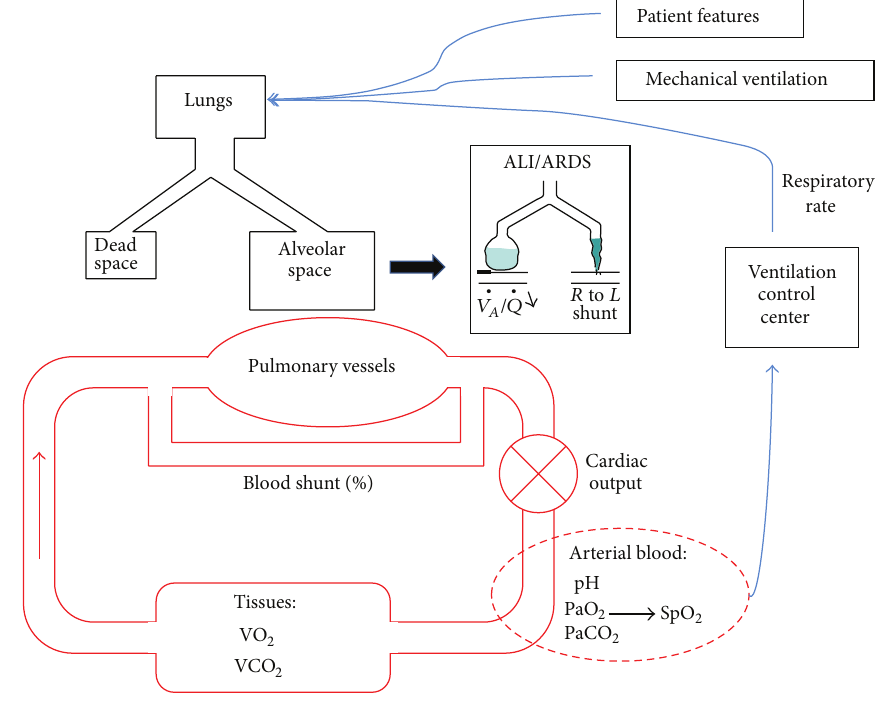
Figure 1: Schematic presentation of the cardiorespiratory model developed by Dickinson and used in the SimulResp simulator. ALI: acute lung injury, ARDS: Acute Respiratory Distress